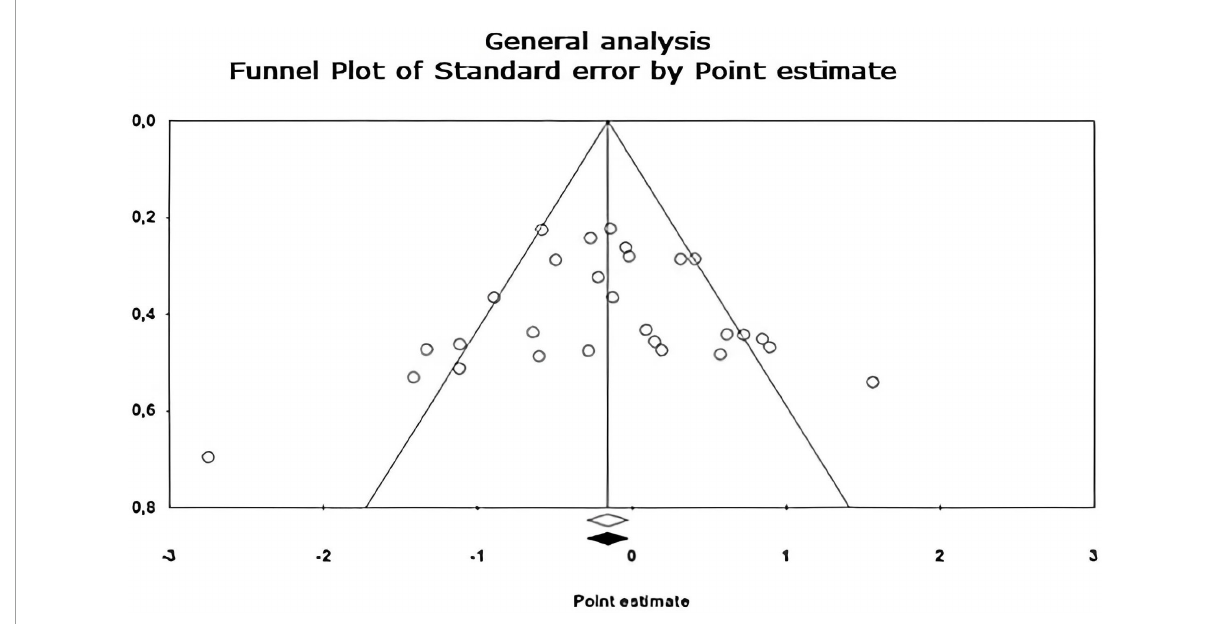
FIGURE6 Funnel plot of publication bias created using the Trim and Fill method (Duval and Tweedie, 2000) shows an estimate of the effect sizes of all UAs. Data obtained from the experiments are shown in white. No data points were imputed.